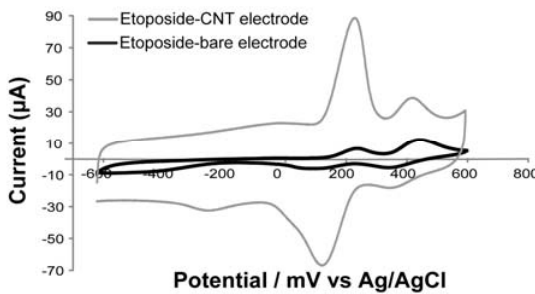
Figure 4. Comparison between cyclic voltammograms obtained with bare electrode (black curve) and CNT-nanostructured electrode (grey curve), in presence of etoposide 100 μ